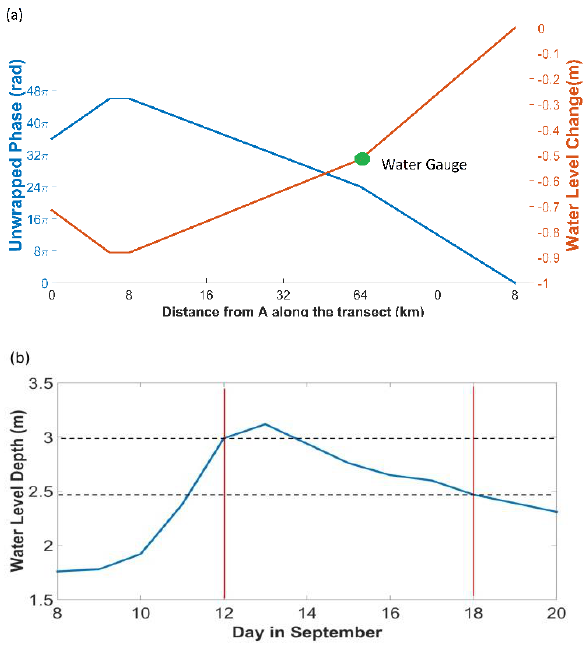
Figure 9. (a) Unwrapped phase and calibrated water level along the Plamdale forested wetland transect (red transect in Figure 8). The green circle marks the position of the water gauge on the transect. (b) Water level time series of the gauge between Sep 8 th and 20 th (after USGS National Water Information System). Two red vertical lines mark the acquisition times of two SAR SLC images (Sep 12 nd and 18 th ) used to form the interferogram shown in Figure